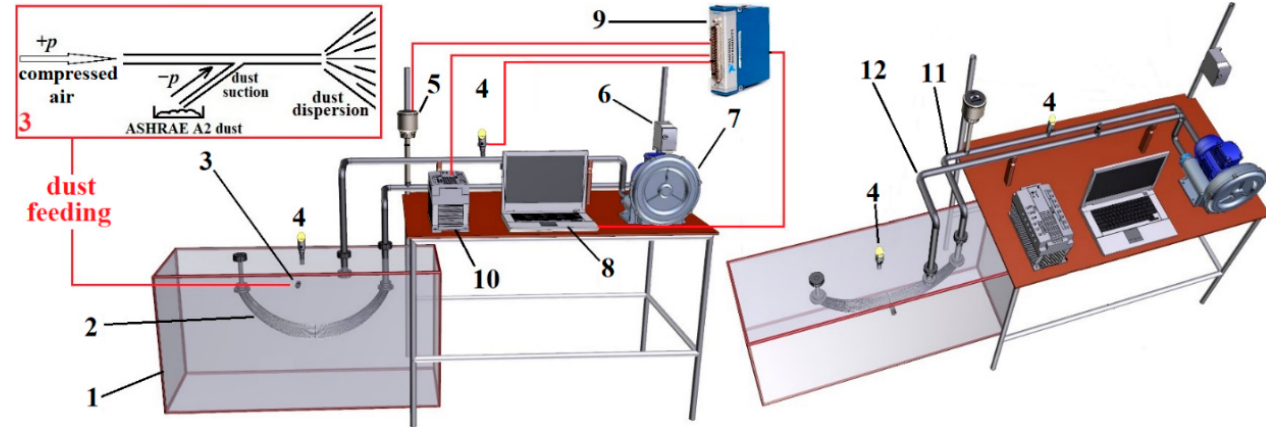
Figure 2. A scheme of the experimental setup: 1 —chamber, 2 —hollow-fiber membrane bundle, 3 —opening for dust dosing, 4 —differential pressure sensor, 5 —air velocity probe, 6 —inverter, 7 —blower, 8 —laptop, 9 —DAQ card, 10 —laboratory power source, 11 —air intake (downstream) pipe, 12 —air return (exhaust) pipe.